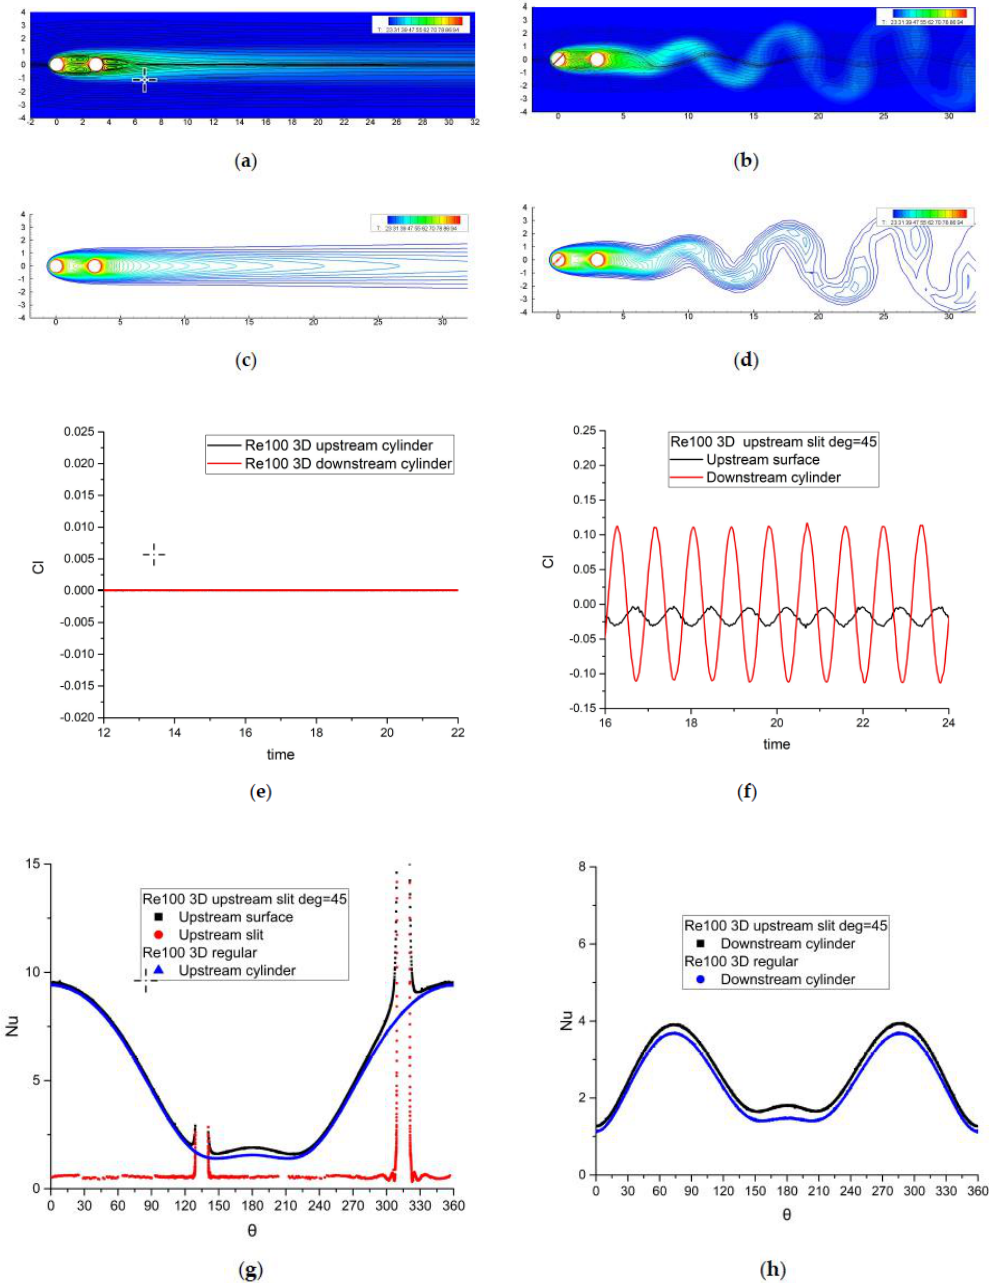
Figure 18. Re = 100, L/D = 3 with slit α = 45°. ( a ‒ c ) Streamlines, temperature contours, and lift history of the regular cylinder array; ( d ‒ f ) streamlines, temperature contours, and lift history of the cylinder array with the slit; ( g ) time mean Nusselt number distribution of the upstream cylinder in regular and slotted array; ( h ) time mean Nusselt number distribution of the downstream cylinder in regular and slotted array.